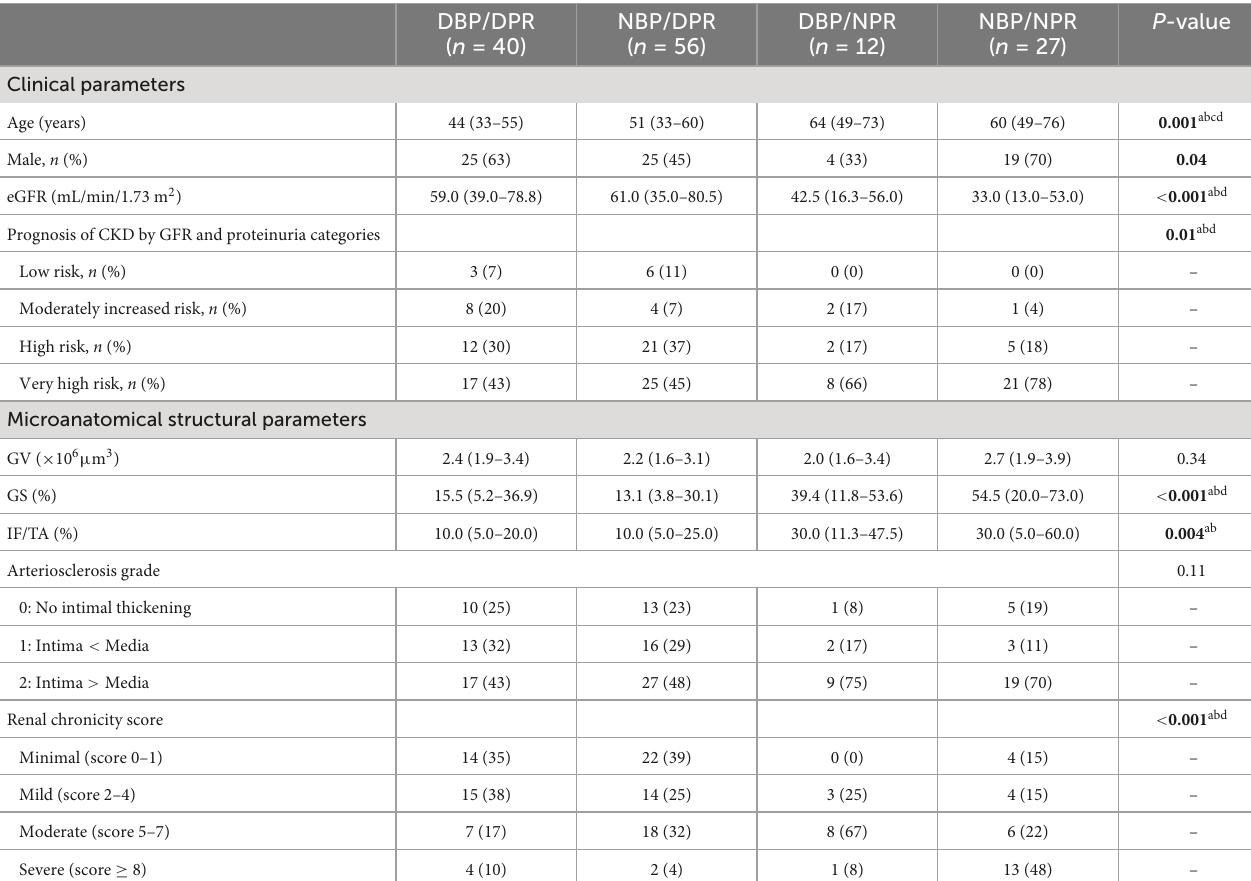
TABLE 4 Clinical and microanatomical characteristics of the subjects according to the dipping and non-dipping blood pressure/pulse rate pattern.